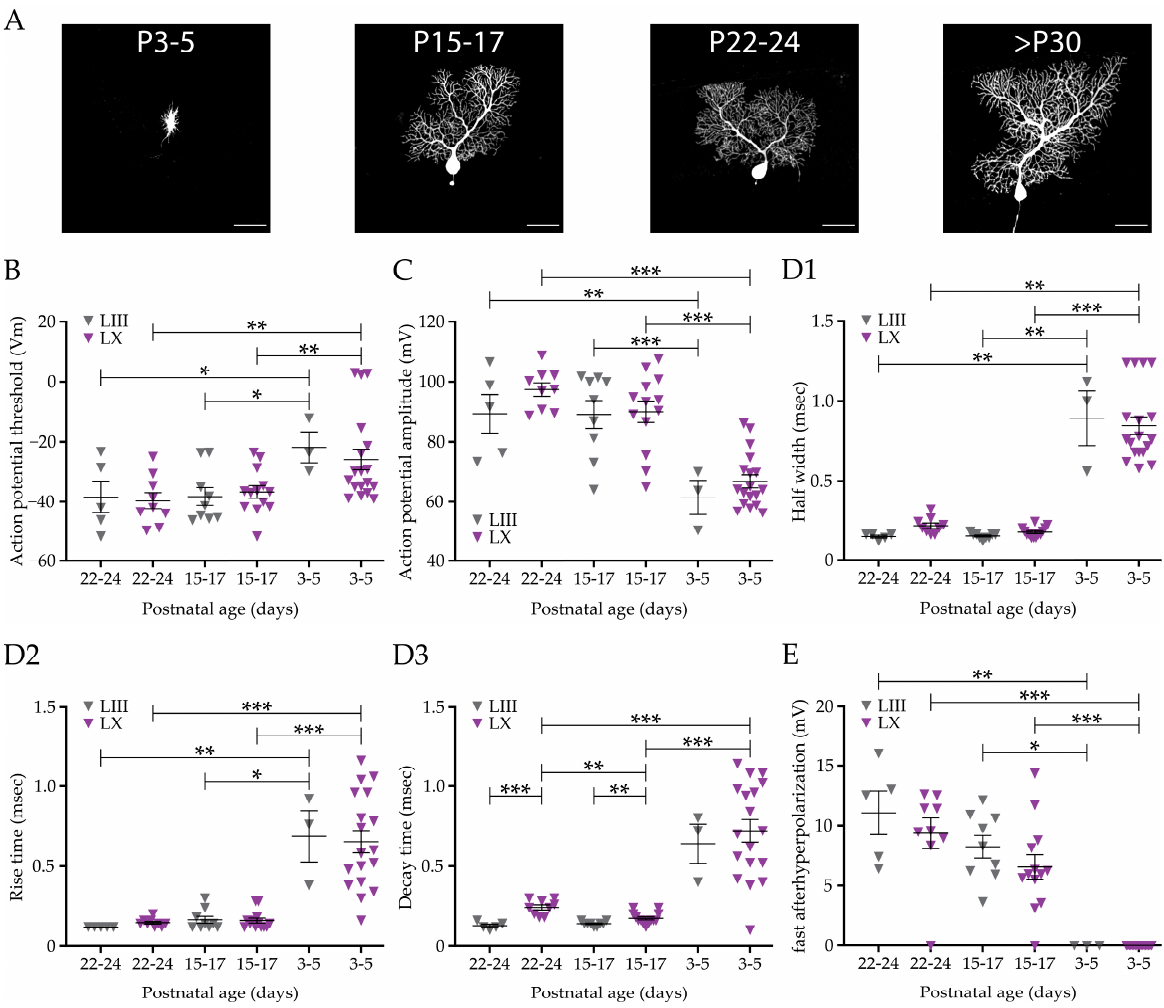
Figure 4. Development of cellular and action potential features compared between Purkinje cell subpopulations. ( A ), Fluorescence images of biocytin-filled PCs revealing the development of morphology from P3–5 until >P30. ( B ), Analysis of action potential threshold in P22–24, P15–17, and P3–5 days old mice, comparing PCs from LIII and LX. ( C ), Similar analysis for AP amplitude. ( D ), Developmental profile of action potential shape, comparing half width ( D1 ), rise time ( D2 ) and decay time ( D3 ). ( E ), Analysis of the development of the fast after hyperpolarization for each subpopulation. See Figure 1 for comparison with >P30 mice. Scale bar in A1, 50 µ m. Asterisks denote: * for p < 0.05, ** for p < 0.01 and *** for p < 0.001. See Table S4 for all statistical